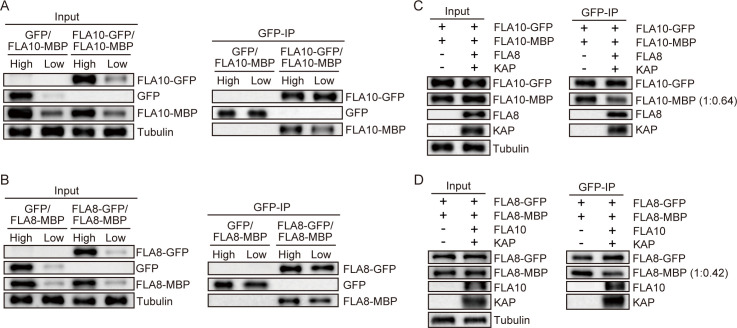
Self-dimerization of FLA10 and FLA8.(A–B) Self-dimerization of FLA10 and FLA8 is not affected by the level of protein expression. Cells were transfected with 7.5-fold differences in the amount of plasmid DNA (high and low as indicated) to induce different levels of protein expression and analyzed by immunoprecipitation with GFP antibody and immunoblotting. (A) Expression of FLA10-GFP and FLA10-MBP. (B) Expression of FLA10-GFP and FLA10-MBP. Cells expressing GFP and FLA10-MBP or FLA8-MBP were used as control. Antibodies used for immunoblotting include anti-GFP, anti-MBP and anti-α-tubulin. (C–D) Self-dimerization of FLA10 and FLA8 in the presence of other subunits of kinesin-II. Cells were transfected with FLA10-GFP and FLA10-MBP alone or including FLA8 and KAP (C) or with FLA8-GFP and FLA8-MBP alone or including FLA10 and KAP (D). Anti-GFP was used for immunoprecipitation. Antibodies against GFP, MBP, FLA10, FLA8, KAP, and α-tubulin were used for immunoblotting as indicated.